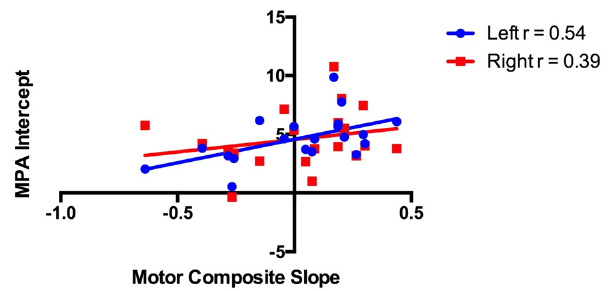
Figure 12. Scatter plot of mean peak acceleration (MPA) intercepts (for right and left arms) and Bayley composite motor slopes of each infant.